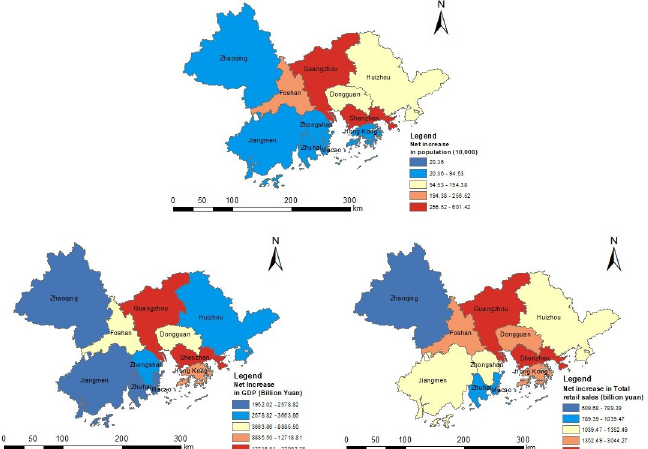
Fig 9. Net increase in the population, GDP and total retail sales of the GBA (2018 vs. 2000). Reprinted background map from the National Catalogue Service for Geographic Information (www.webmap.cn) under a CC BY license, with permission from the National Geomatics Center of China, original copyright 2020.